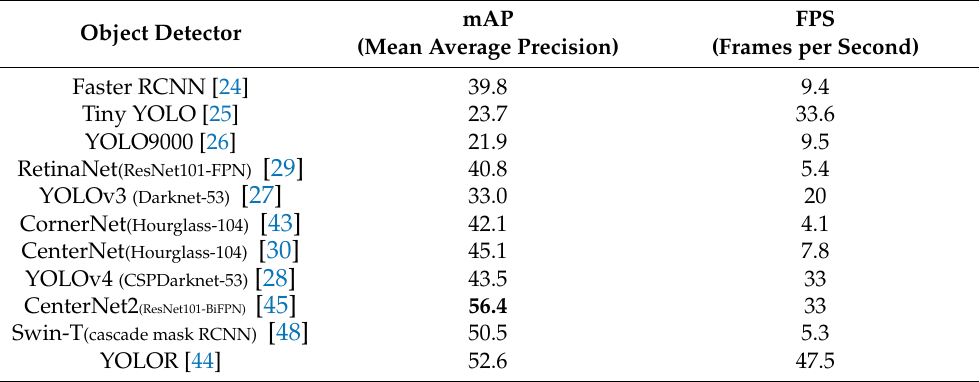
Table 1. Performance of object detectors on COCO test-dev. ( ) means the backbone of the model. Frames per second (FPS) of every detector were measured on a machine with NVIDIA RTX 2080 TI. mAP FPS Object Detector (Mean Average Precision) (Frames per